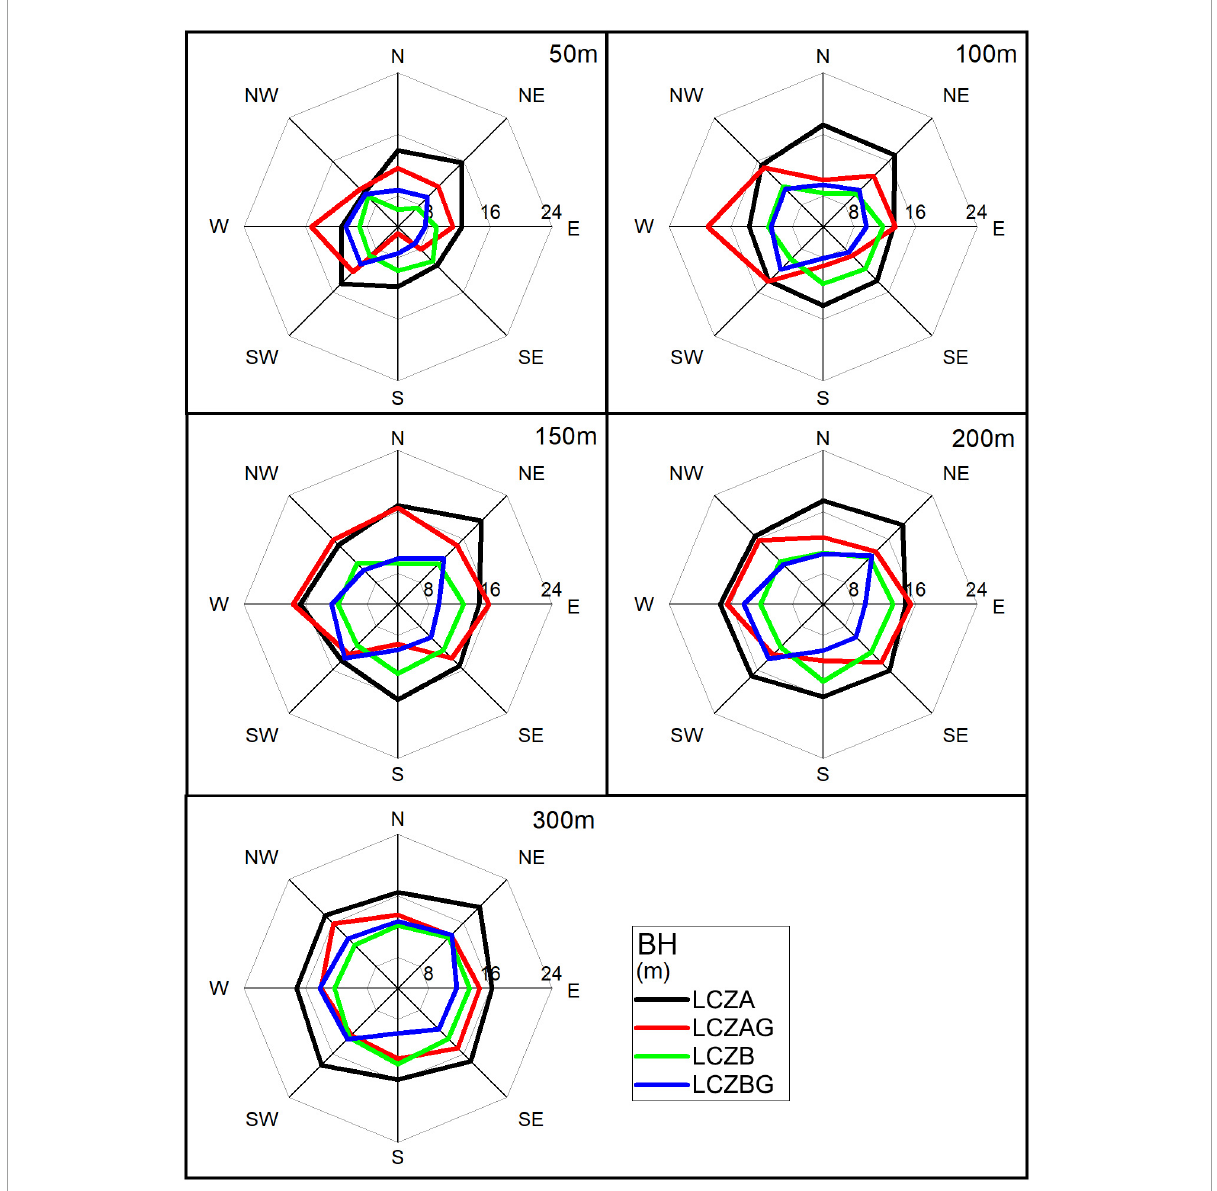
FIGURE9 The distribution of BH around parks, and eight axes present the height of buildings located around parks in eight